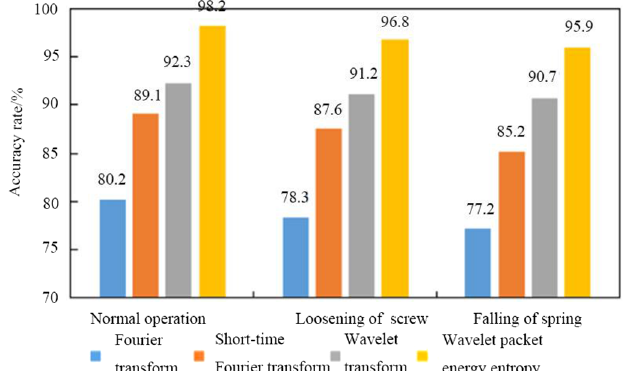
Fig. 7. Recognition accuracy rate of the fault detection model based on different feature extraction methods.